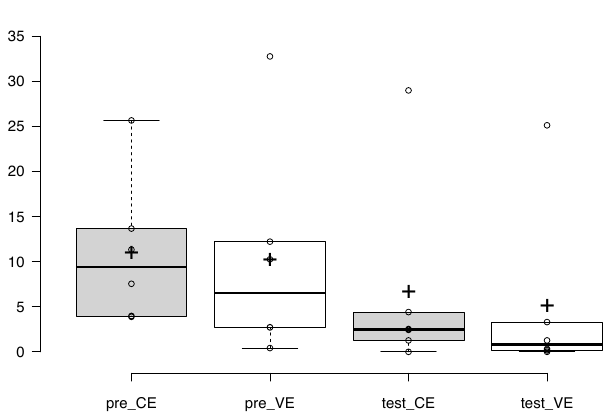
Figure 5. Boxplot of constant and variable error (CE and VE) in pre-test and test